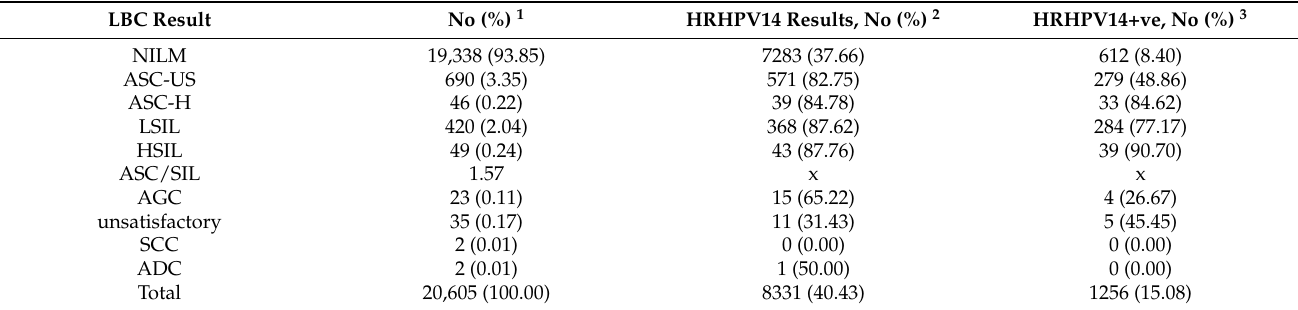
Table 11. Cyto-virologic correlations (CVC) for the study population for the CQI protocol (round